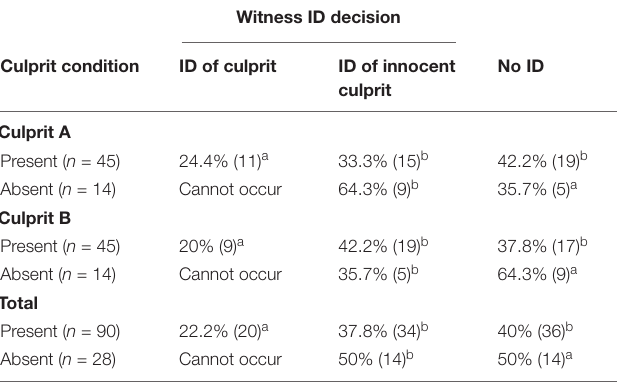
TABLE 2 | Mugbook selection numbers for each culprit and in total.